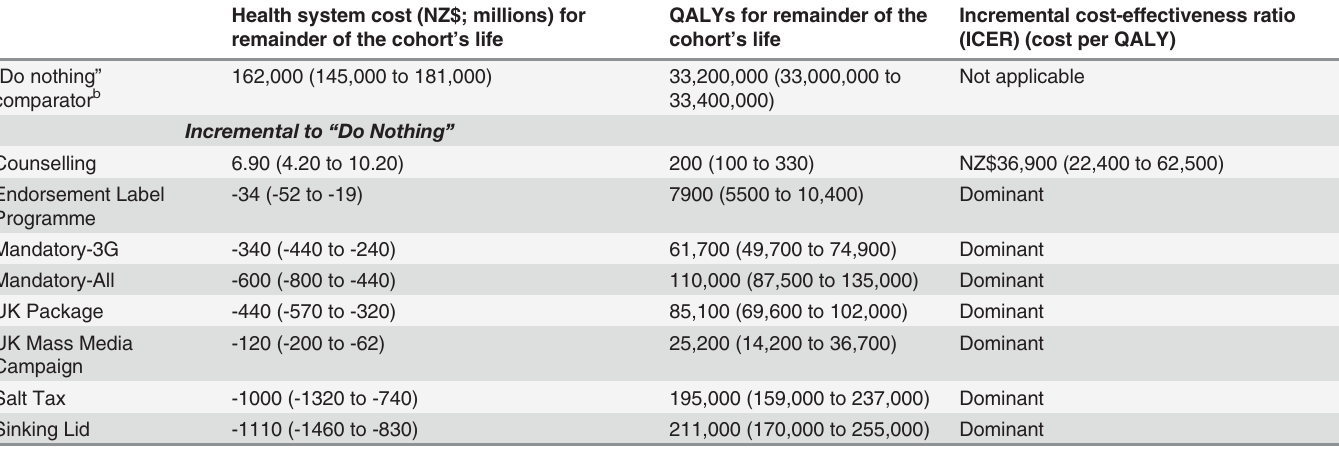
Table 4. Population level results for the cost, health gain and cost-effectiveness of the interventions (95% uncertainty intervals in parentheses) a . Health system cost (NZ$; millions) for remainder of the cohort ’ s